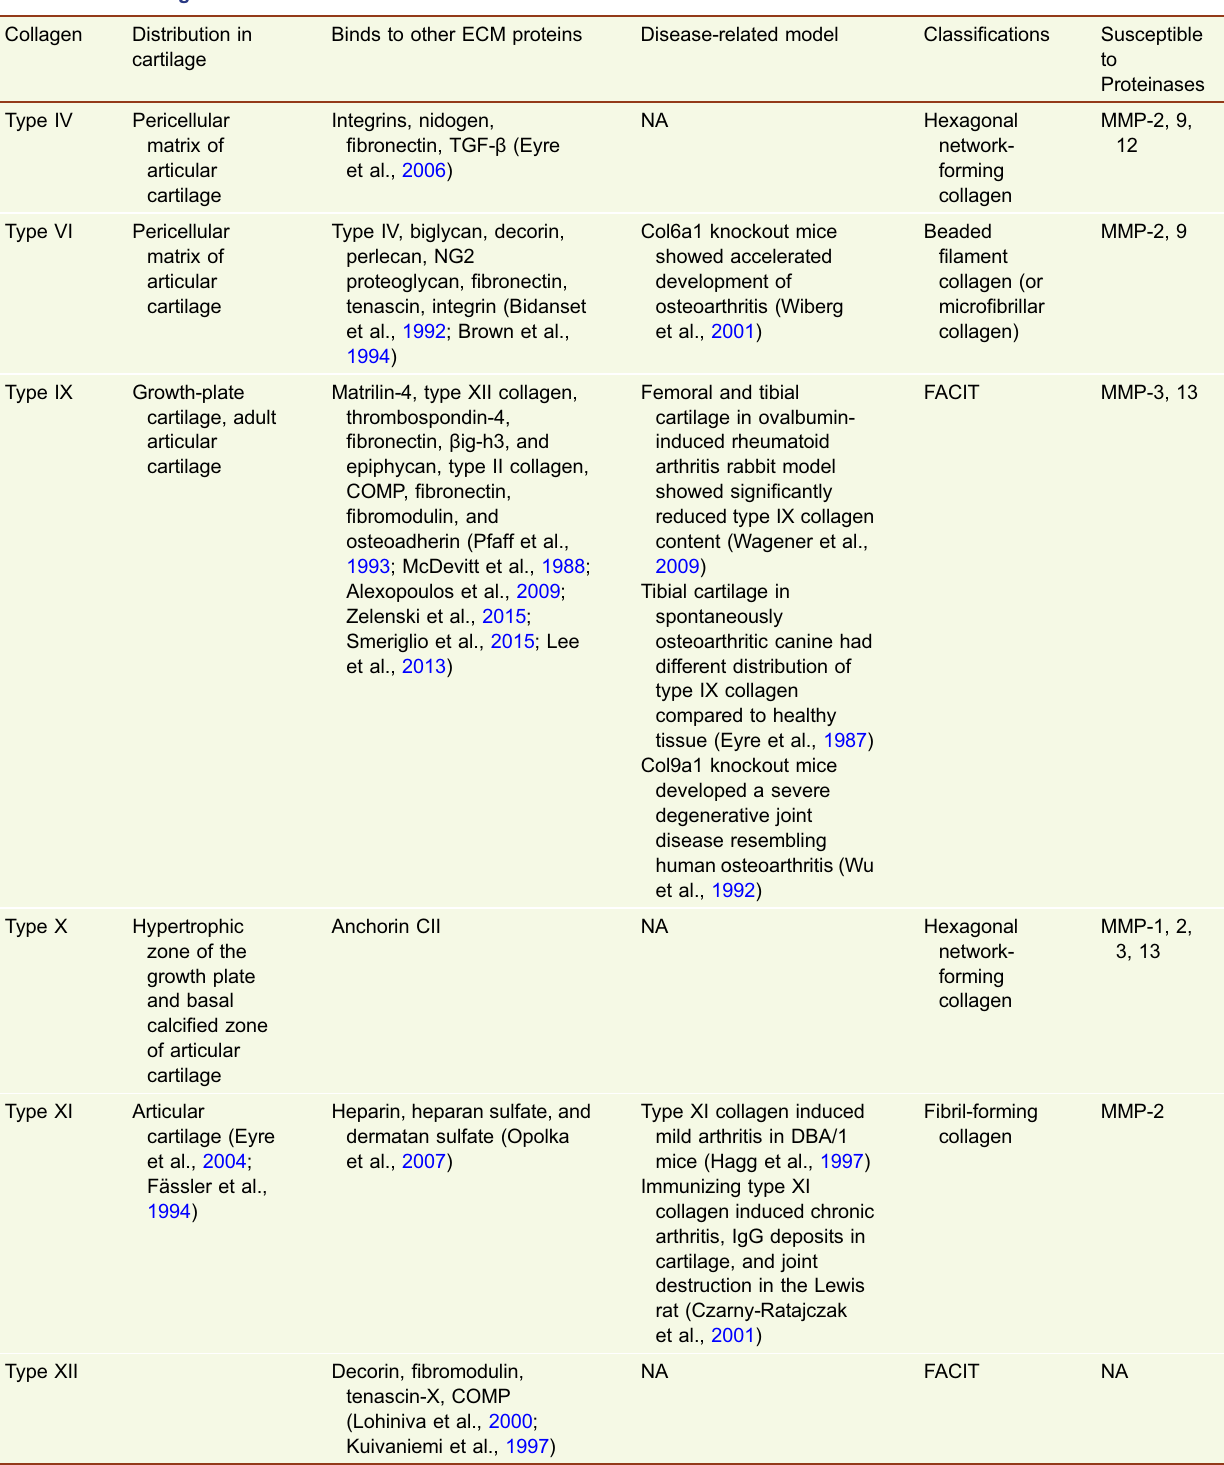
Table 1. Minor collagen